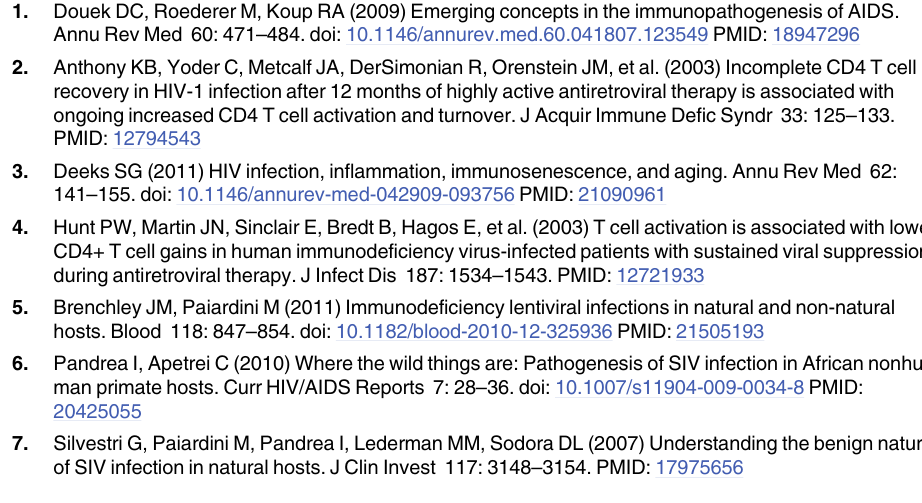
S4 Fig. Rifaximin (RFX) and sulfasalazine (SFZ) impacts the levels of inflammation during acute and early chronic SIVsab infection of pigtailed macaques (PTMs). Levels of proin- flammatory cytokines were consistently lower in SIVsab-infected PTMs receiving RFX+SFZ (red) compared to untreated controls (black): TNF- α (a); I-TAC (b); and C-reactive protein (CRP) (c). S5 Fig. Rifaximin (RFX) and sulfasalazine (SFZ) improves the natural history of SIVsab infection during acute and early chronic SIVsab infection of pigtailed macaques (PTMs). Levels of viral replication were significantly lower in SIVsab-infected PTMs receiving RFX +SFZ (red) compared to untreated controls (black) (a). While no significant impact of RFX +SFZ treatment could be observed in circulating CD4 + T cells (b), a less prominent depletion of mucosal CD4 + T cells could be observed in treated PTMs (c). S6 Fig. Rifaximin (RFX) and sulfasalazine (SFZ) reduces the levels of coagulation biomark- ers during acute and early chronic SIVsab infection of pigtailed macaques (PTMs). Levels of d-dimer (a) and tissue factor (b) were significantly lower in SIVsab-infected PTMs receiving RFX+SFZ (red) compared to untreated controls (black). Shown are the average values for each group and standard error of